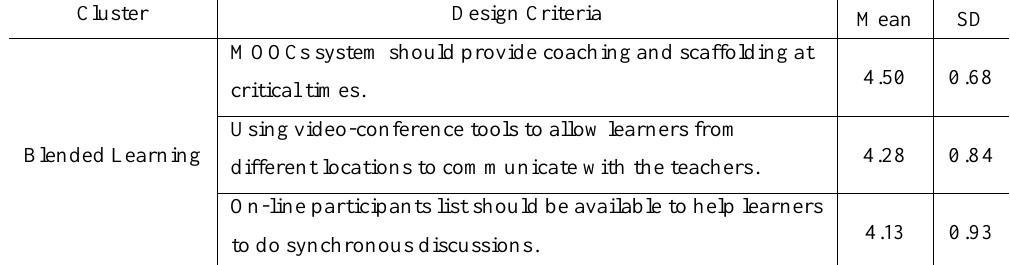
Design Criteria of bMOOCs Cluster Design Criteria Mean SD